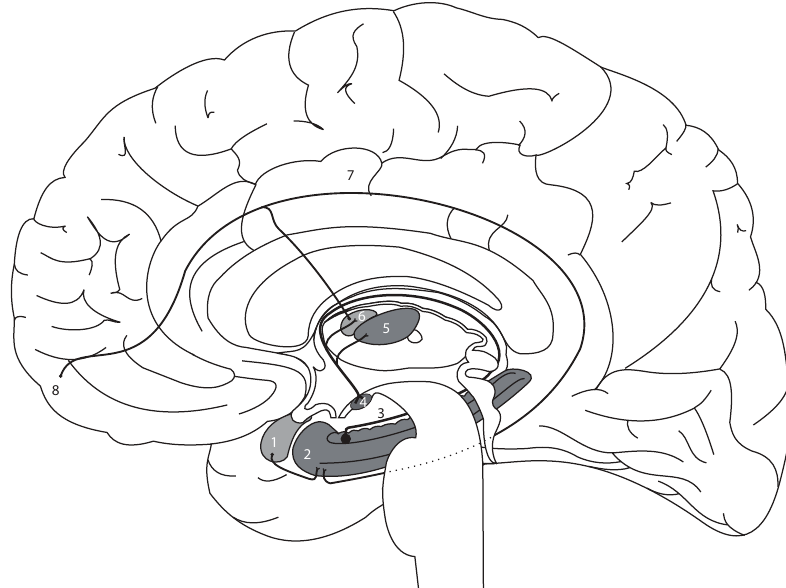
FIGURE 3: Anatomical representation of the neural pathways involving the main limbic structures in the human brain, adapted from Nieuwenhuys et al. [4]. It includes (1) amygdala, (2) hippocampus, (3) fornix, (4) mammillary body, (5) mediodorsal thalamic nucleus, (6) anterior nucleus of thalamus, (7) cingulate gyrus, and (8) prefrontal